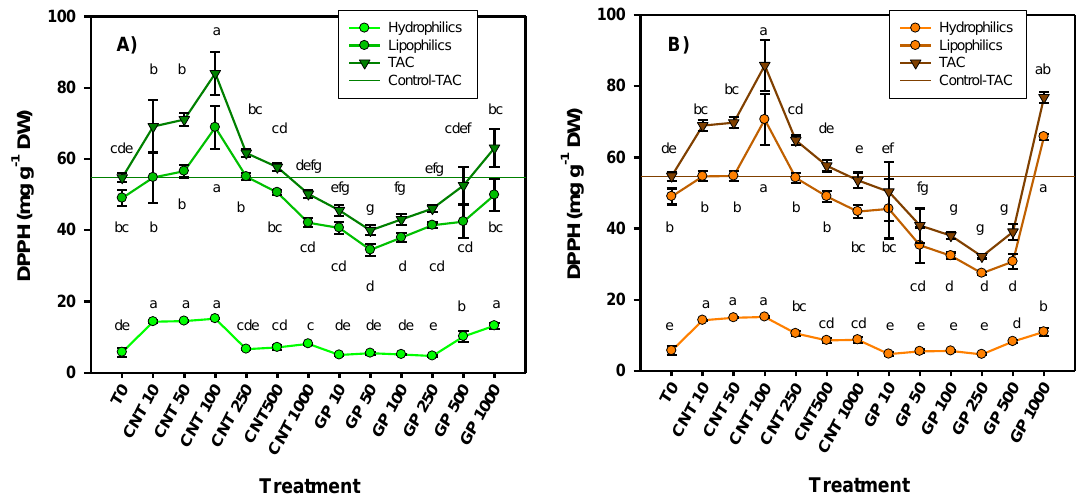
Figure 4. Antioxidant capacity in tomato seedlings treated with carbon nanomaterials applied via foliar ( A ) and drench ( B ). TAC: total antioxidant capacity. T0: control; CNTs: carbon nanotubes; GP: graphene; DW: dry weight; 10, 50, 100, 250, and 500 represent the mg L − 1 applied of each carbon nanomaterial. Di ff erent letters indicate significant di ff erences among treatments according to Duncan ( α = 0.05). n = 5 ± standard error.